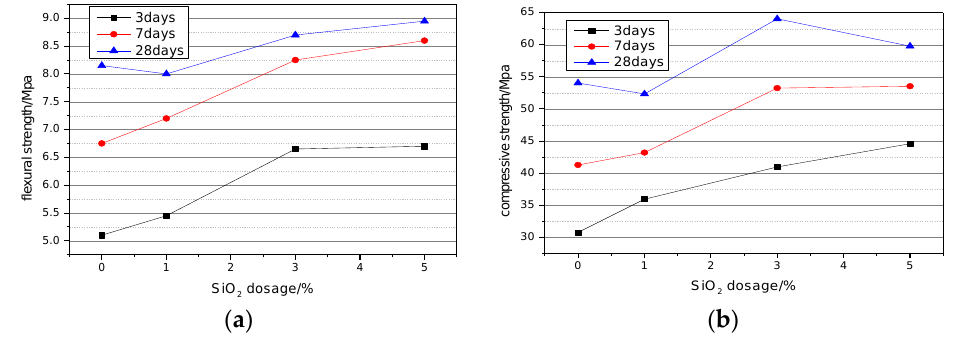
Figure 6. Flexural and compressive strength of cement contained Nano-SiO 2 . ( a ) Flexural strength; and ( b ) compressive strength.